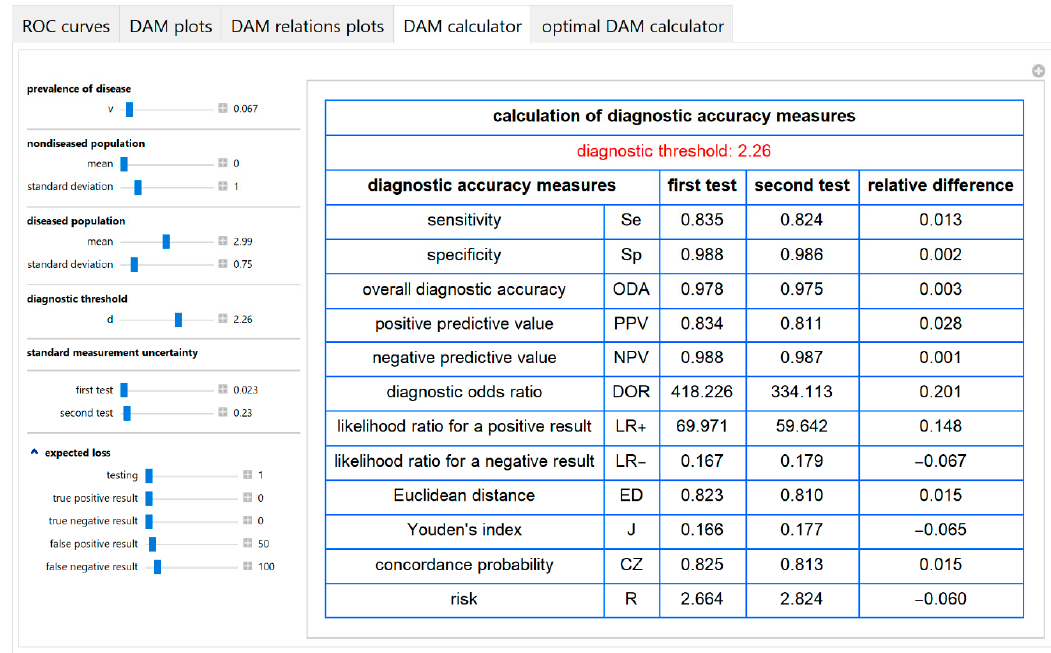
Figure 10. DAM calculator module screenshot. Calculated diagnostic accuracy measures of two screening or diagnostic tests measuring the same measurand with different uncertainties and their relative differences, with the settings at the left. Diagnostics 2020 , 10 , x FOR PEER REVIEW